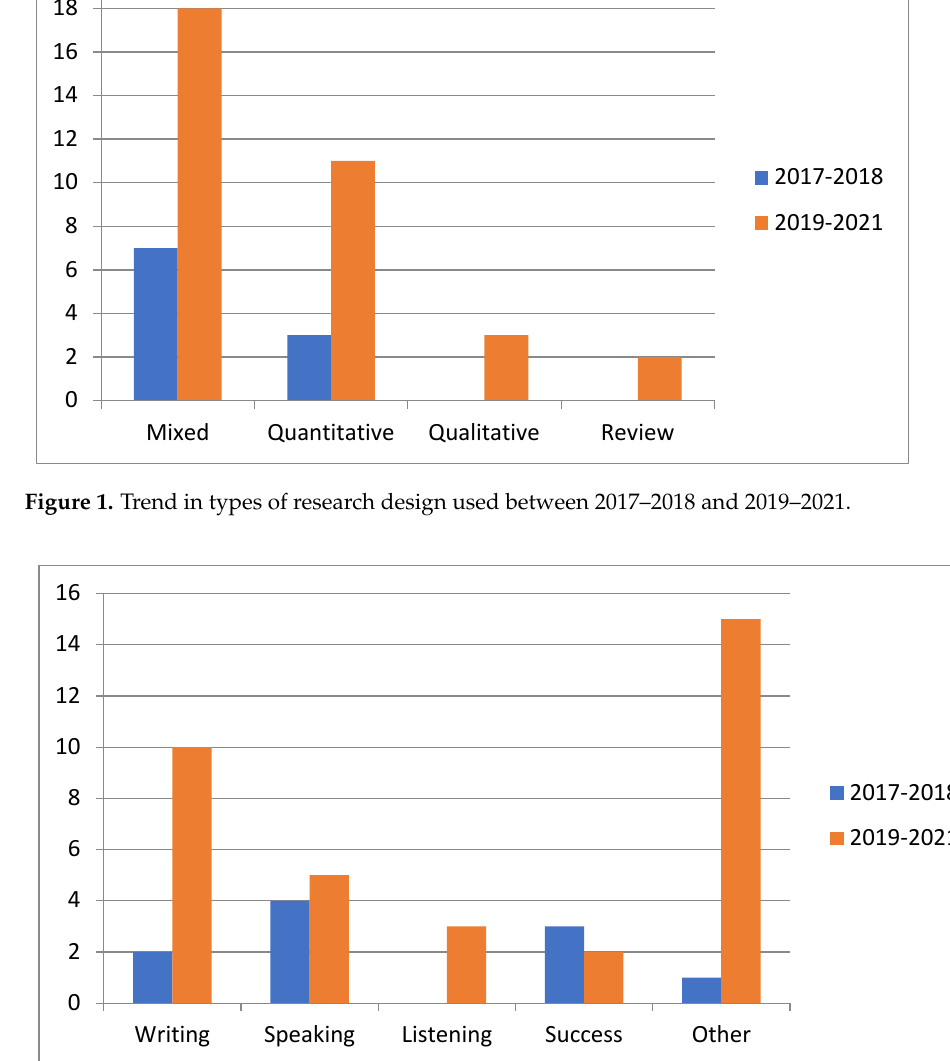
Figure 1. Trend in types of research design used between 2017 ‐ 2018 and 2019 ‐ 2021.